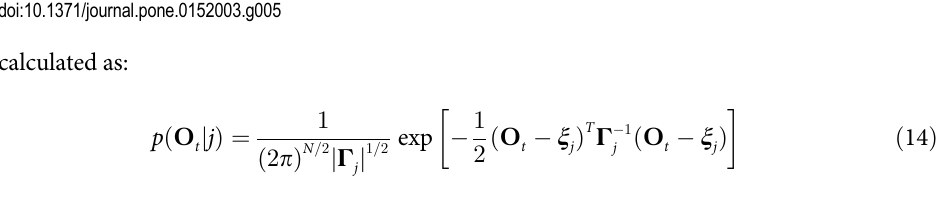
Fig 5. Architecture for creation of topological